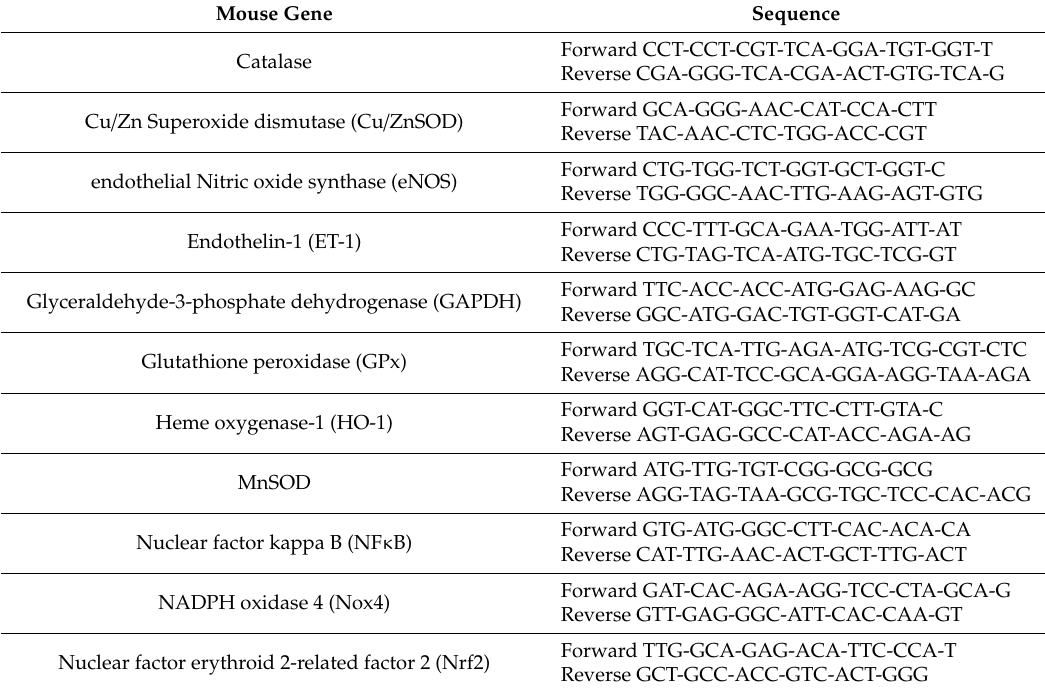
Table 1. Primers used for reverse-transcribed-quantitative polymerase chain reaction (RT-qPCR)